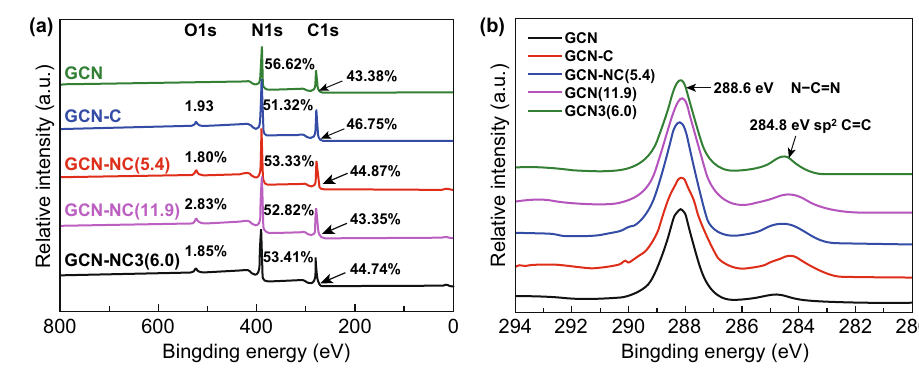
Fig. 2 a XPS full survey and b C 1 s spectra of GCN, GCN-C, GCN-NC(5.4), GCN-NC(11.9), and GCN-NC(6.0)